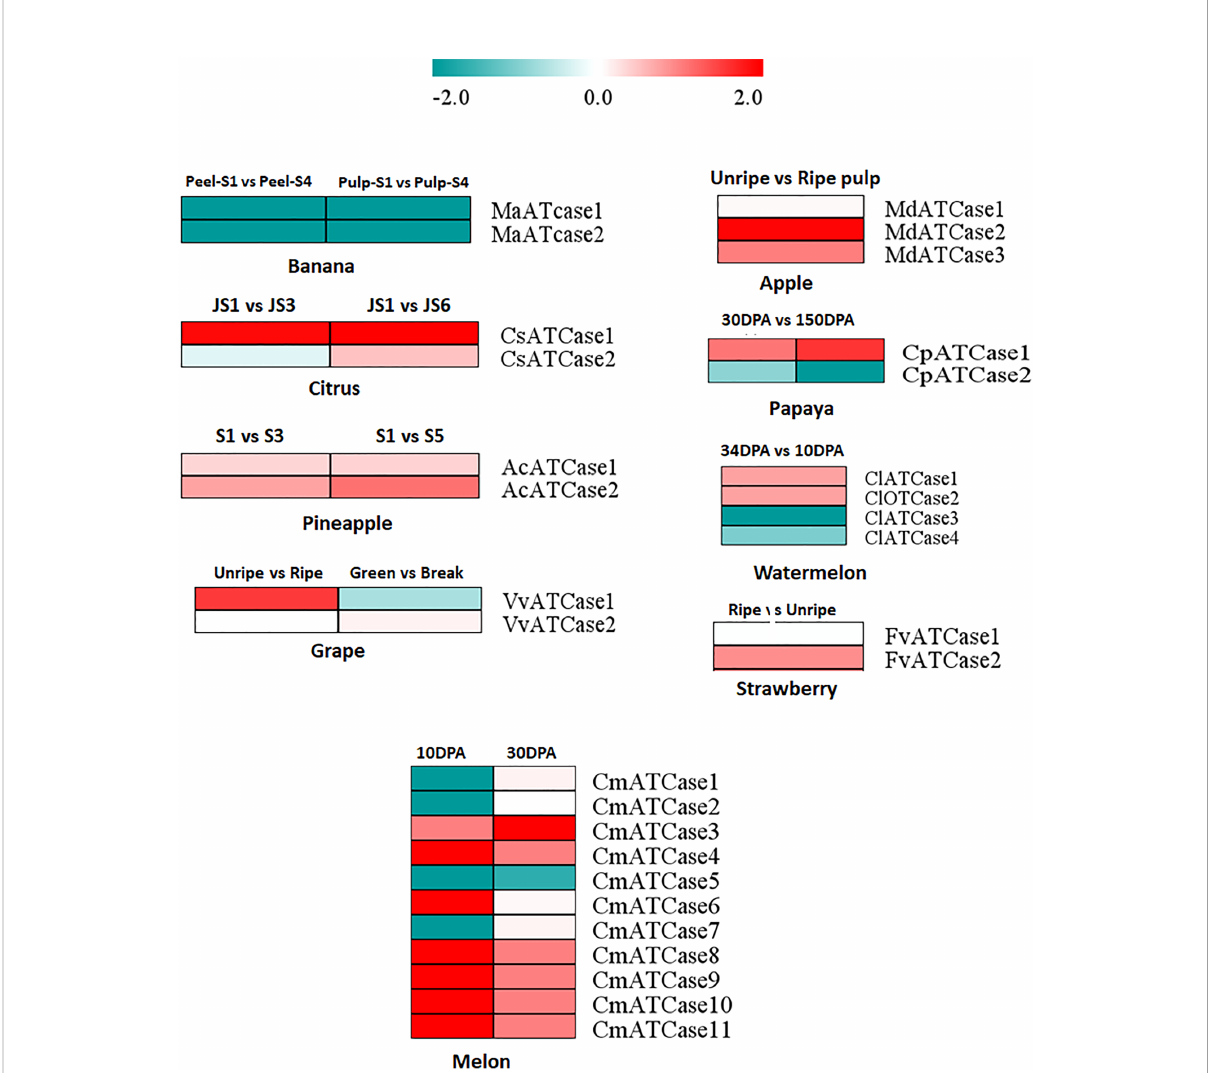
FIGURE 5 The heat map representation of the differential expression pro fi le at the log2 fold change scale of carbamoyltransferase genes in different climacteric and non-climacteric fruits in different developmental and ripening